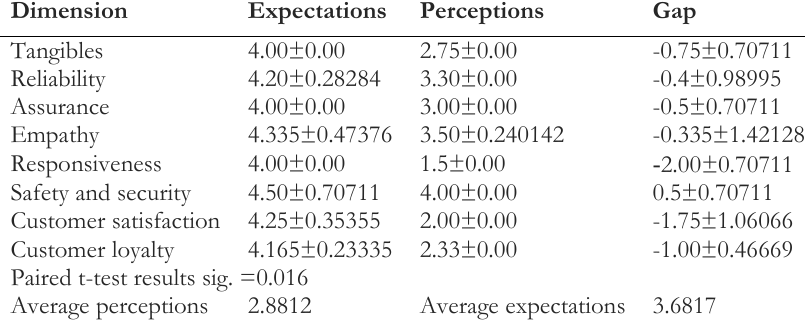
Table 8. Gap quality analysis of reverse support services - unit